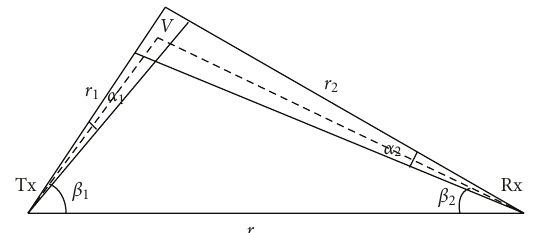
Figure 1: NLOS UV communication link geometry, depicting elevated transmitter beam and receiver